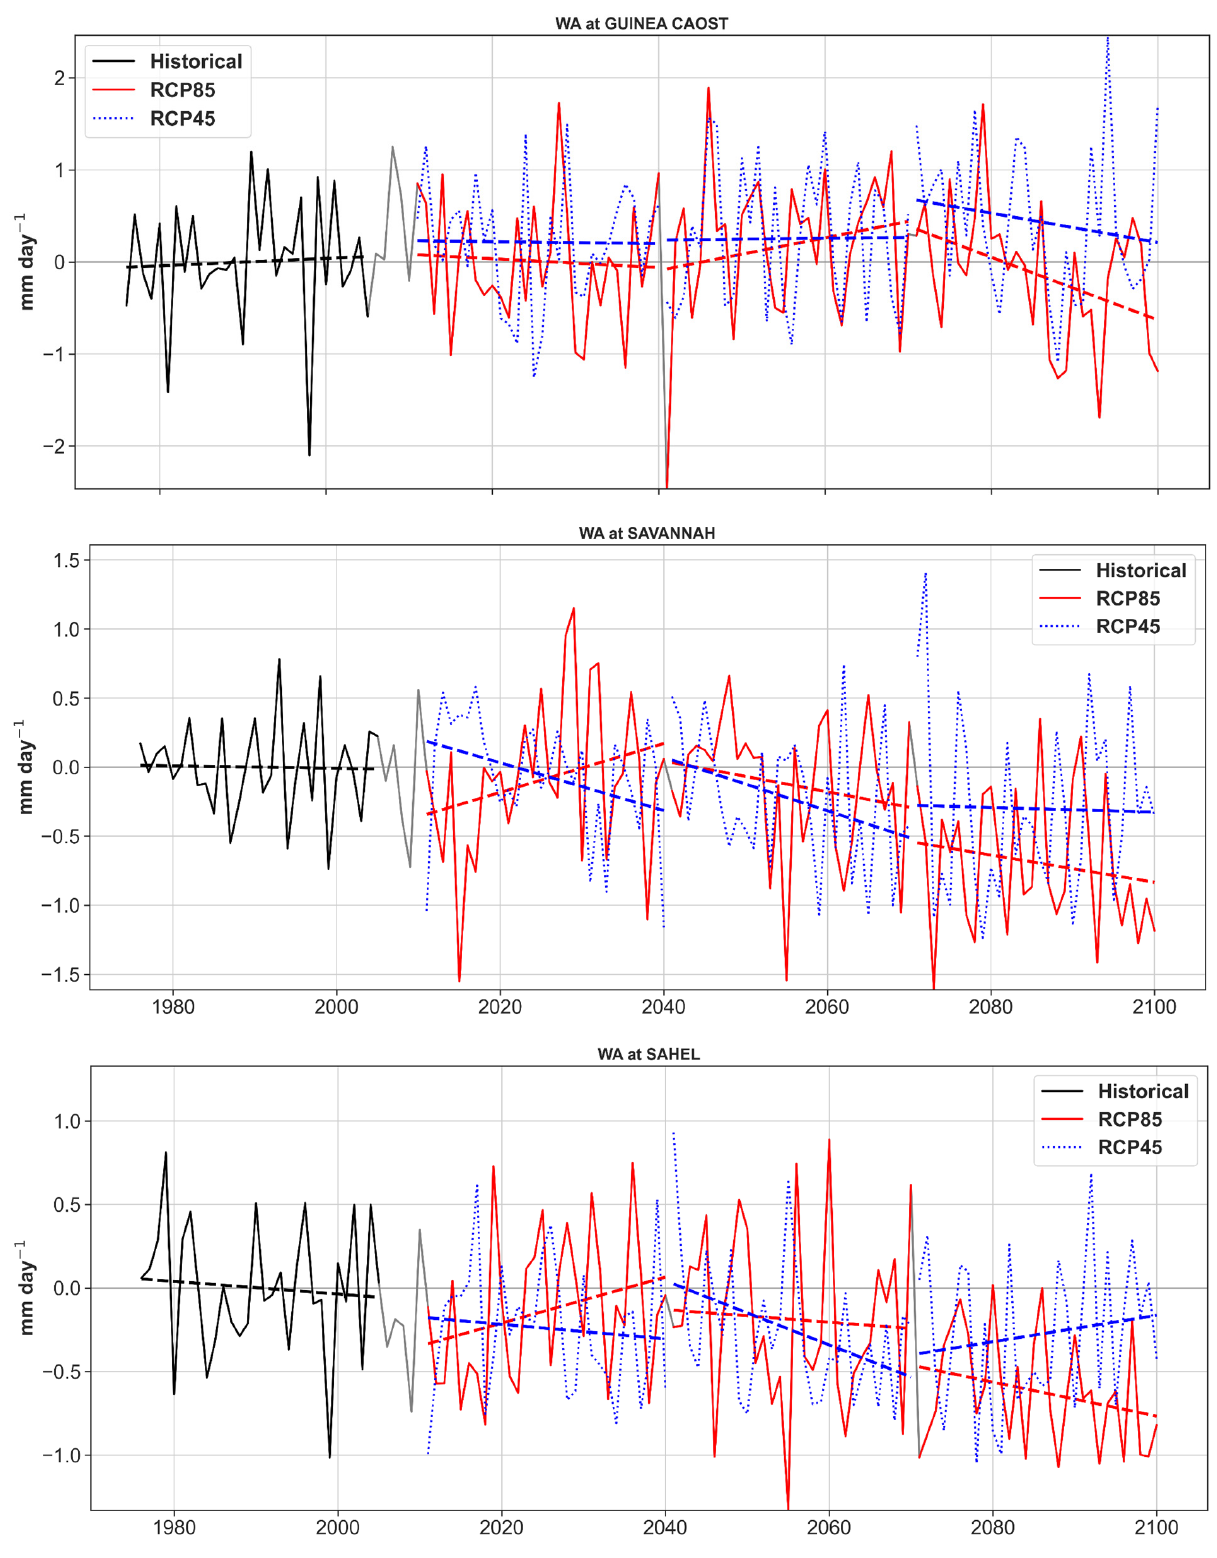
Figure 10. Same as Figure 8, but for WA.